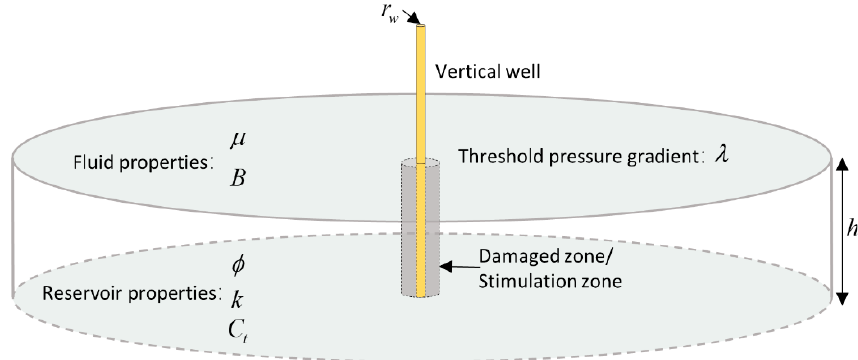
Figure 2. Schematic diagram of the reservoir and well model used in this work.